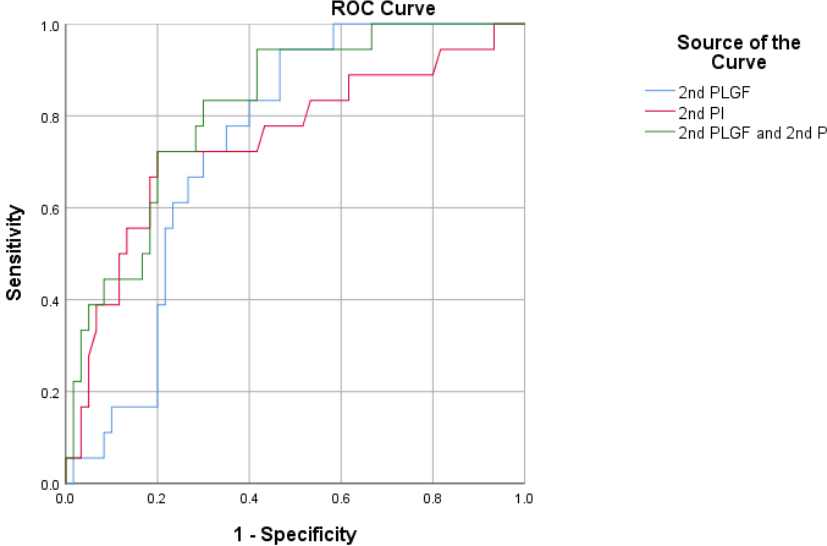
Figure 6. Receiver operating characteristic curve showing the clinical discrimination of different markers alone or in combination in the detection of mild preeclampsia.